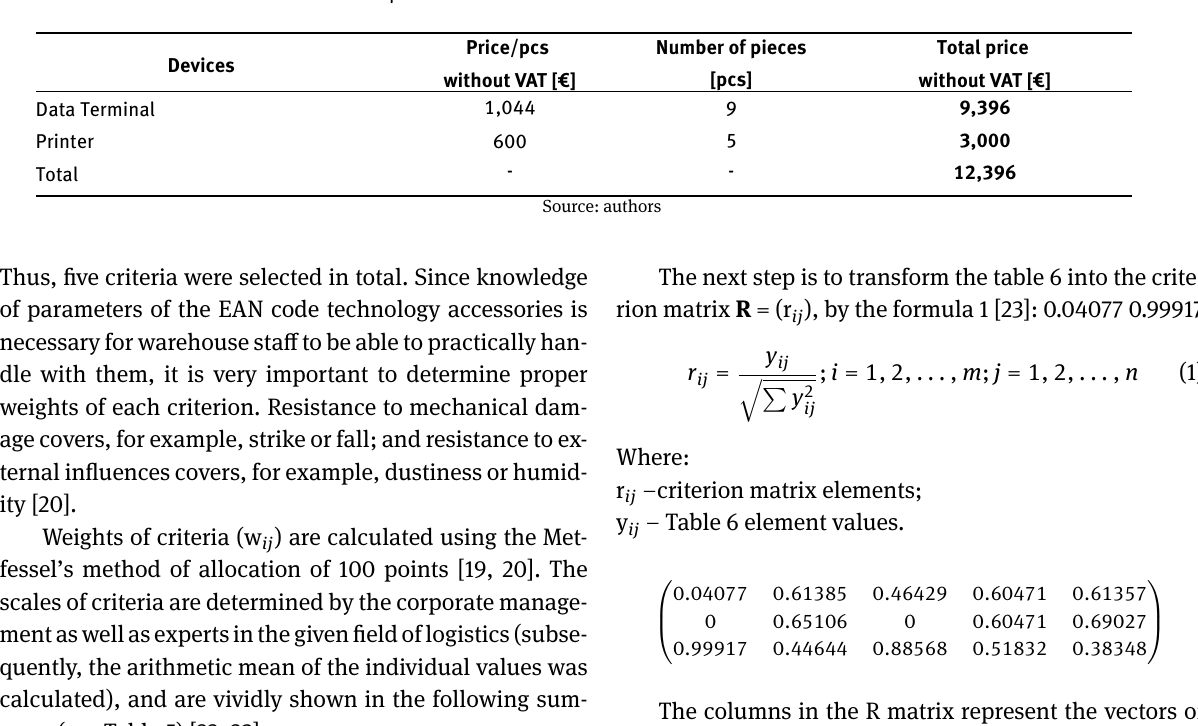
Price/pcs without VAT